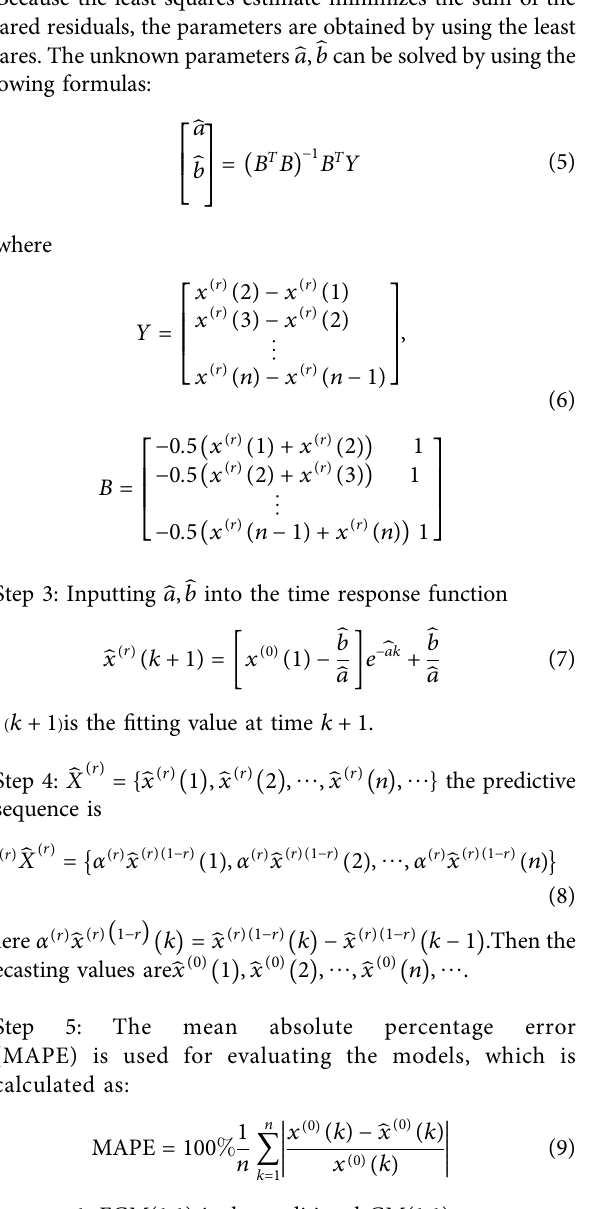
TABLE 3 | Fitting results of Beijing PM 2.5